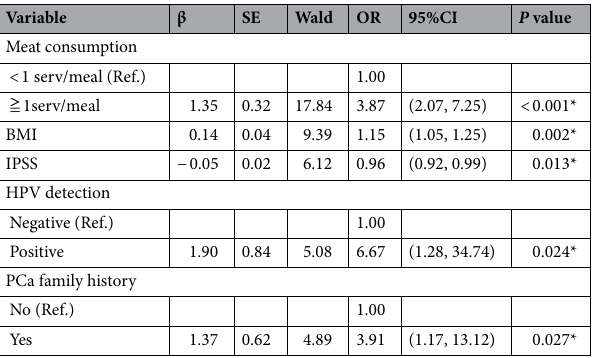
Table 4. Forward stepwise logistic regression of risk factors for PCa. * P <